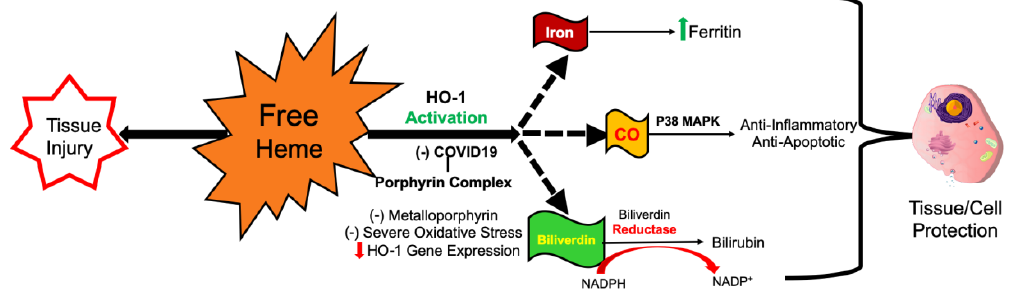
increases, eventuallyout-competinghemeleadingtoincreasingreactiveoxygenspecies(ROS)formation. The result is less production of ferritin, Fe, bilirubin, and carbon monoxide (CO). This may be part of the reason why COVID-19 patients have fluctuations in ferritin and bilirubin, which are